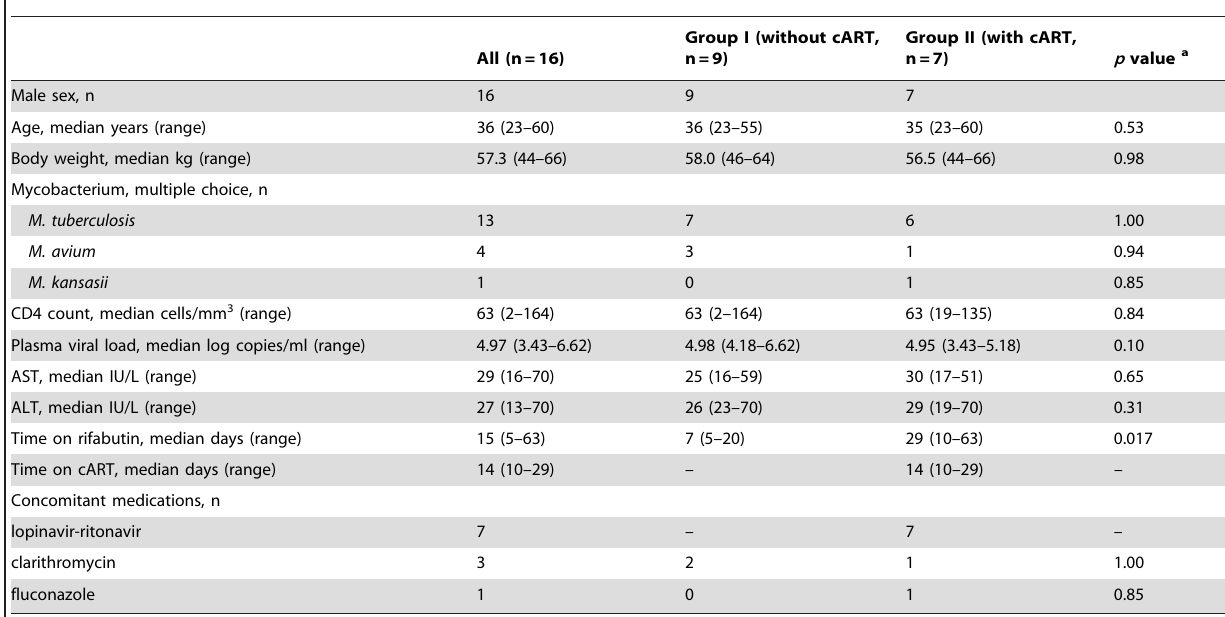
Table 1. Characteristics of study